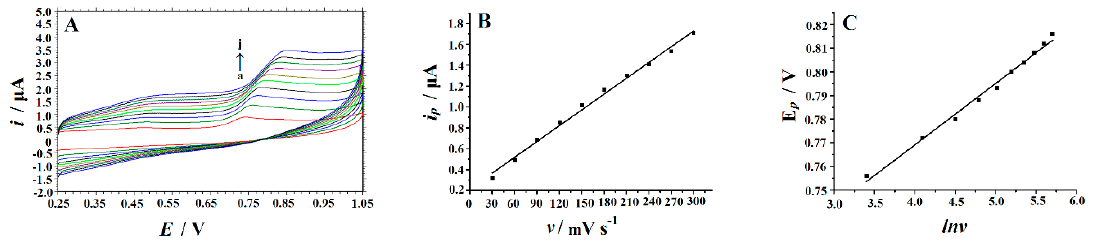
Figure 6. ( A ) The cyclic voltammograms of 0.1 mM Trp in 0.1 M phosphate buffer (pH 7.0) obtained on the MIP/ABPE at different scan rates (a–j: 30, 60, 90, 120, 150, 180, 210, 240, 270, 300 mV·s − 1 ); ( B ) The plot of the peak current versus the scan rate; ( C ) The plot of the peak potential versus the Napierian logarithm of the scan rate. Accmulation potential: − 0.1 V; Accmulation time: 60 s; scan rate: 0.1 V s − 1 .